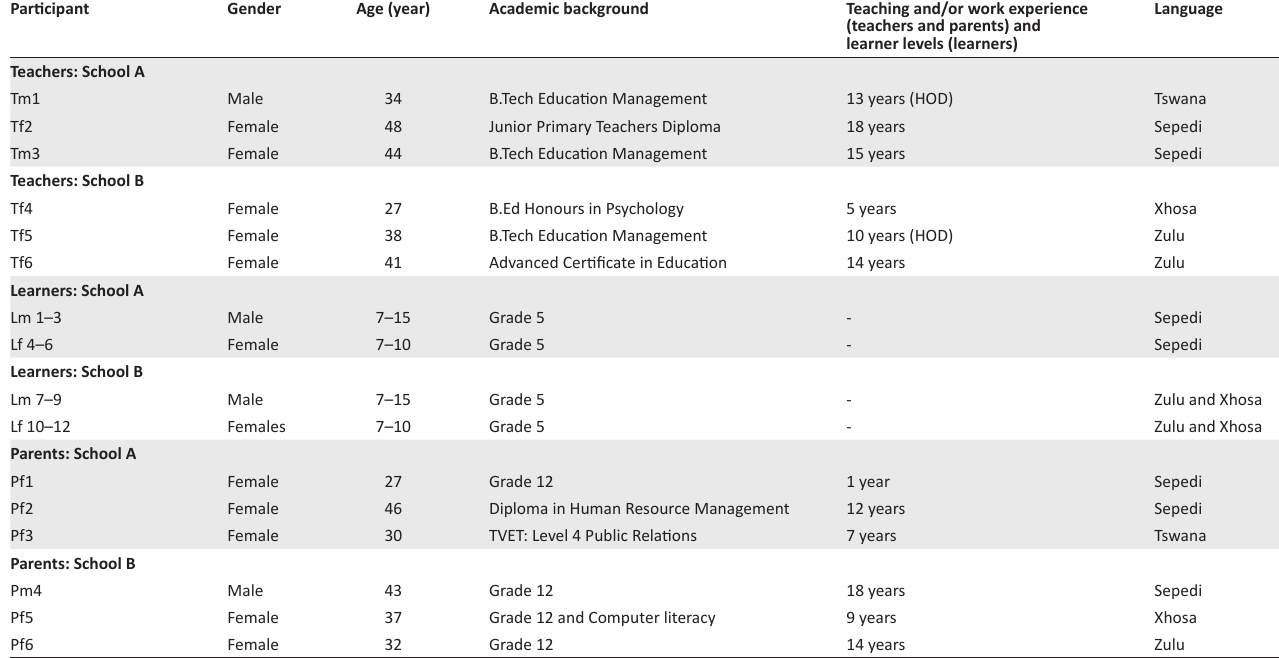
TABLE 1: Demographic information of the study participants.